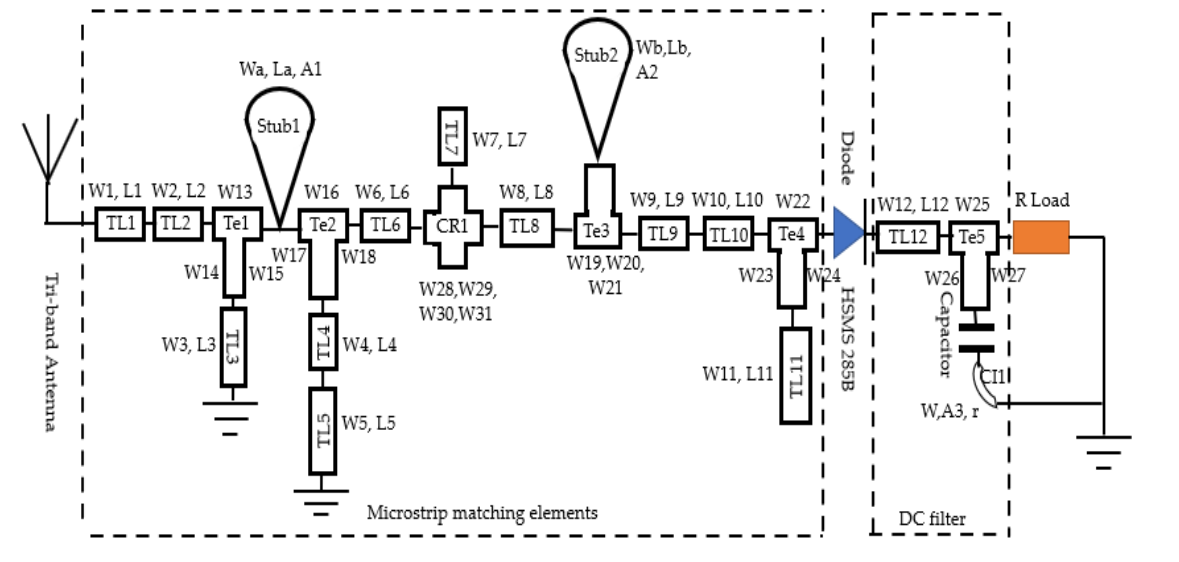
Figure 7. Topology of triple band rectifier. Table 2. Rectifier microstrip line dimensions.